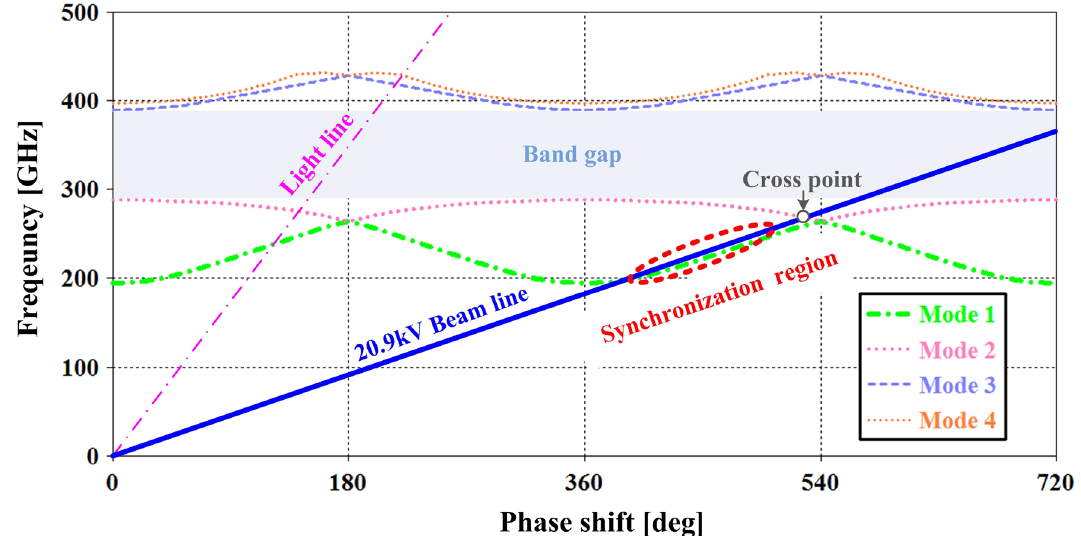
Figure 4. The Brillouin curve (from HFSS): the dash dot red line is the dispersion curve of the fundamental mode in the PWSWG SWS, the solid blue line is the electron-beam curve with a voltage 20.9 kV. Parameter